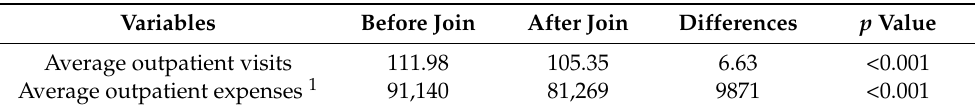
Table 5. The differences in medical utilization among patients participating in the Pharmaceutical Home Care Pilot Program ( N =